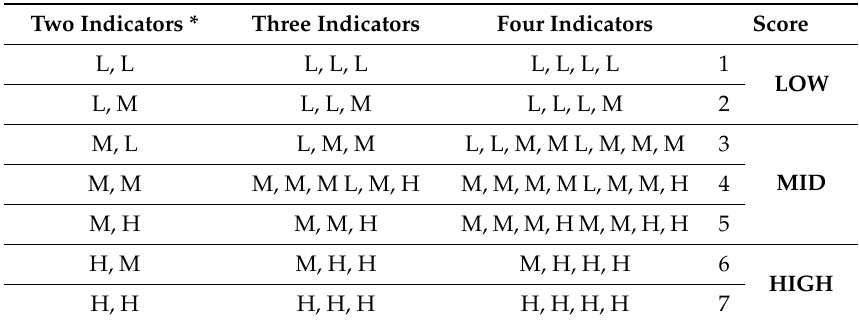
Figure 1. Framework for assessing quality referee–player interactions. Table 1. Example of determining the assessment for the dimension of positive climate of the REFASS tool (based on Pianta, Hamre, Mintz 2012). Table 2. The method to determine the assessment of individual dimensions based on their indicators. Two Indicators * Three Indicators Four